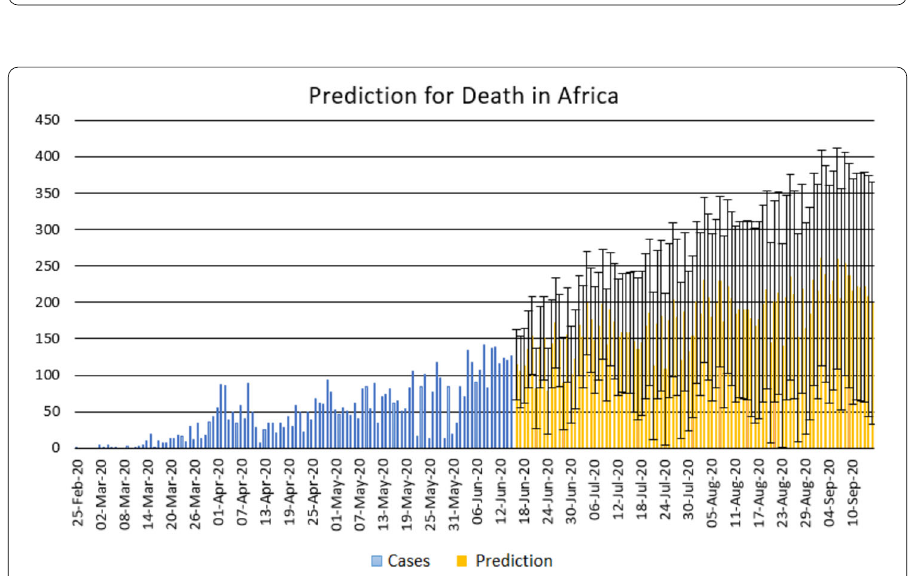
Figure 12 Prediction for deaths in Africa using Forecast Sheet